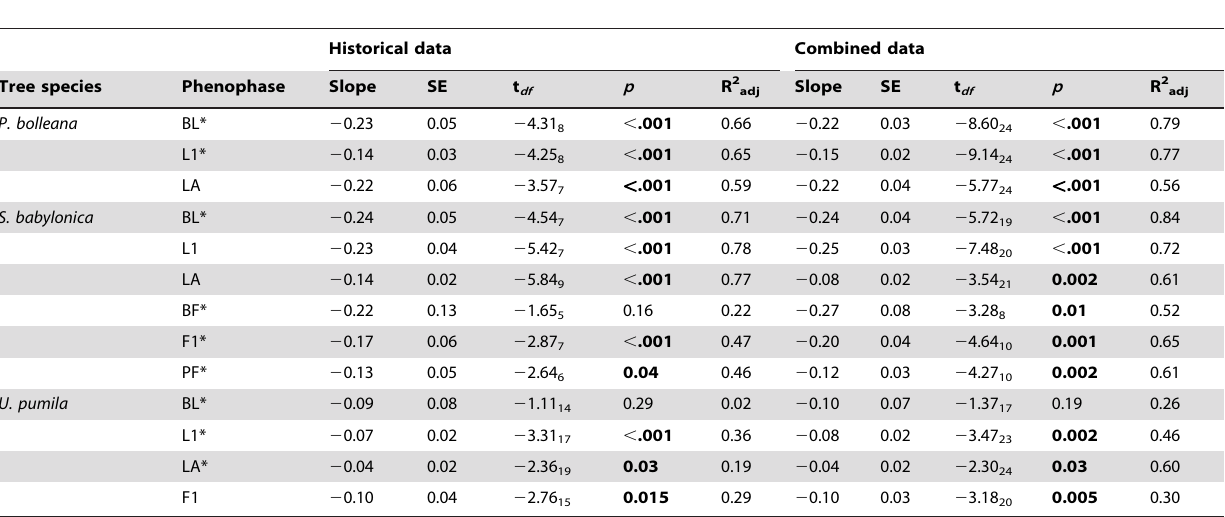
Table 3. Comparison of best phenological regression models for combined and historical